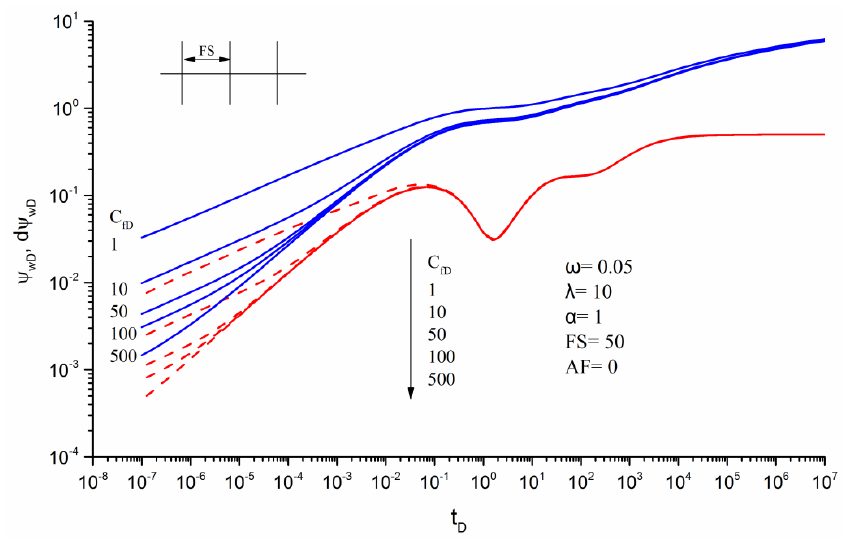
Figure 5. The pseudo-pressure responses for a multi-fractured horizontal well with different fracture conductivities.